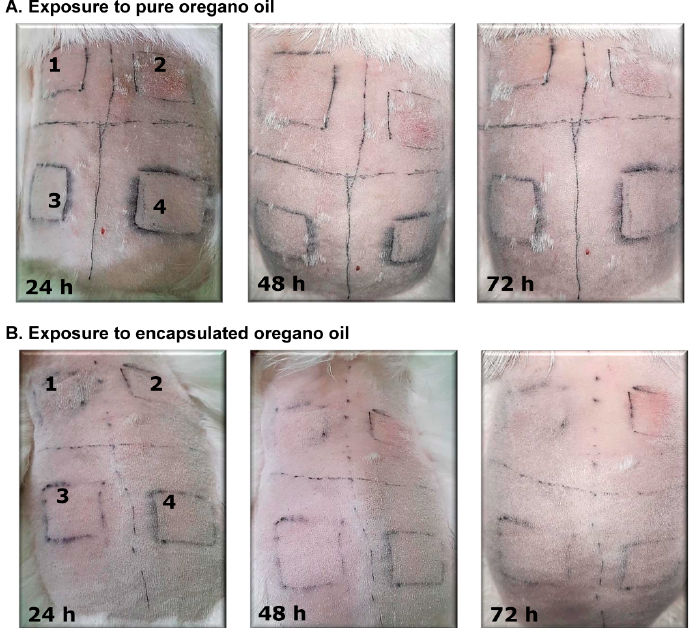
Figure 7. Skin irritation test for pure and encapsulated oregano oil. Legend: 1—administered concentration: 0.1% for pure oregano oil and 0.01% for encapsulated oregano oil; 2—positive control (10% sodium dodecyl sulphate); 3—negative control (sunflower oil); 4—administered concentration: 1% pure oregano oil, 0.1% encapsulated oregano oil.